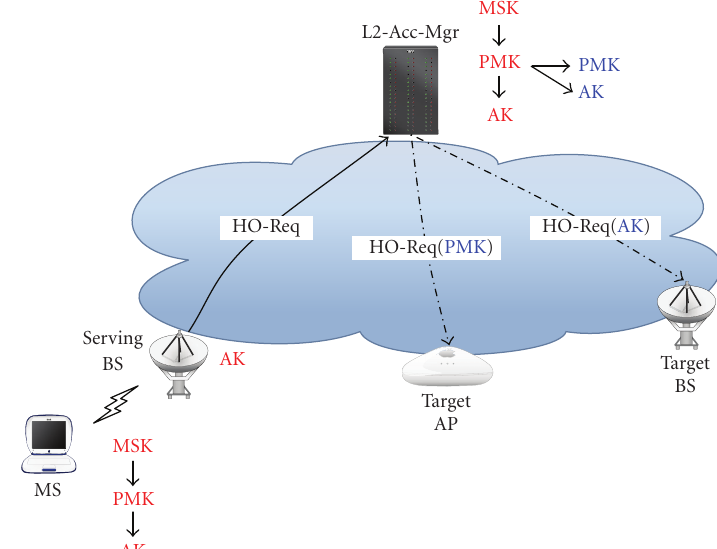
Figure 6: Proactive key distribution, Scenario